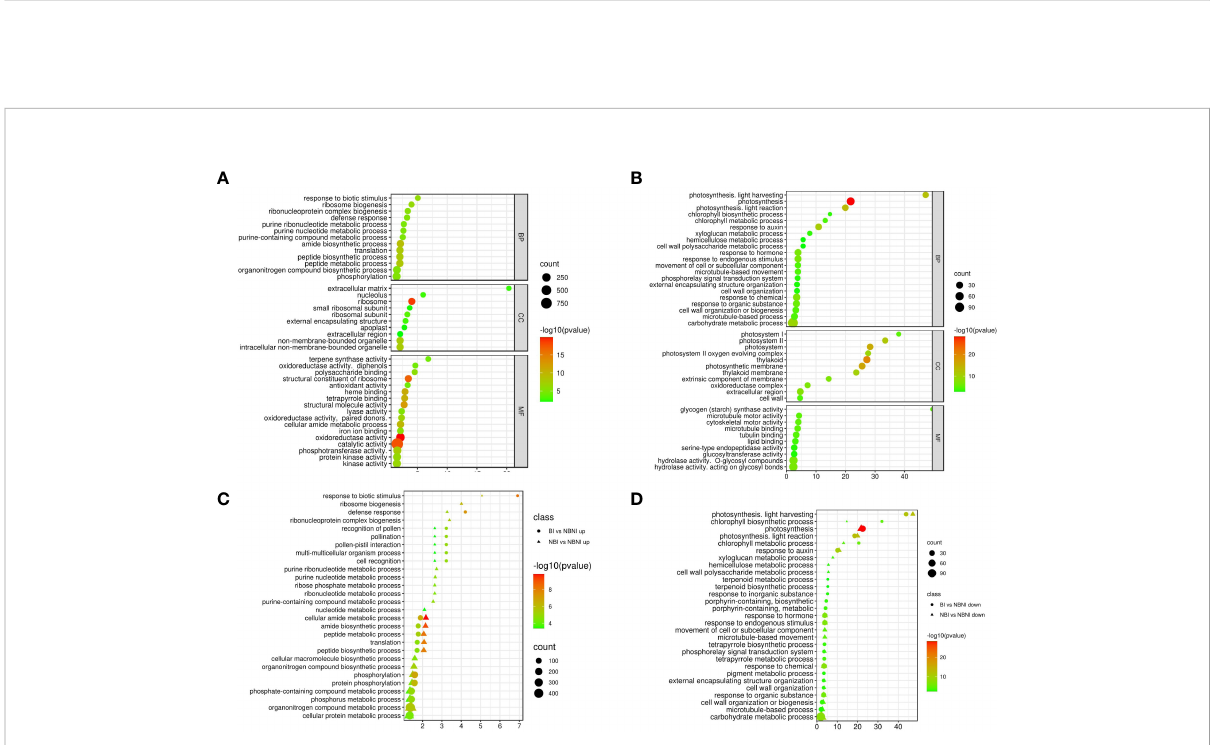
FIGURE 4 GO enrichment analysis for functional annotation of differentially expressed genes (DEGs). Pathway-enrichment bubble plots of upregulated (A) and downregulated (B) DEGs in Fragaria vesca Hawaii-4 leaves that were not treated with b -aminobutyric acid (BABA) and then infected with Botrytis cinerea . BP; biological process, MF; molecular function, CC; cellular compartment. Comparison of enriched GO-terms in the biological process category for NBI vs. NBNI (triangles) and BI vs. NBNI (circles) for upregulated (C) and downregulated (D) DEGs. Treatment combinations: B. cinerea -infected (NBI; No-BABA and Infected), mock-infected (NBNI; No-BABA and Non-Infected), BABA-treated and B. cinerea infected (BI; BABA and Infected), and BABA-treated and mock-infected (BNI; BABA and Non-Infected). X-axis shows log2-fold enrichment values. Plotted terms are selected based on log2 > 1 enrichment and P < 0.005. A comprehensive list of enriched terms can be found in Supplementary Table